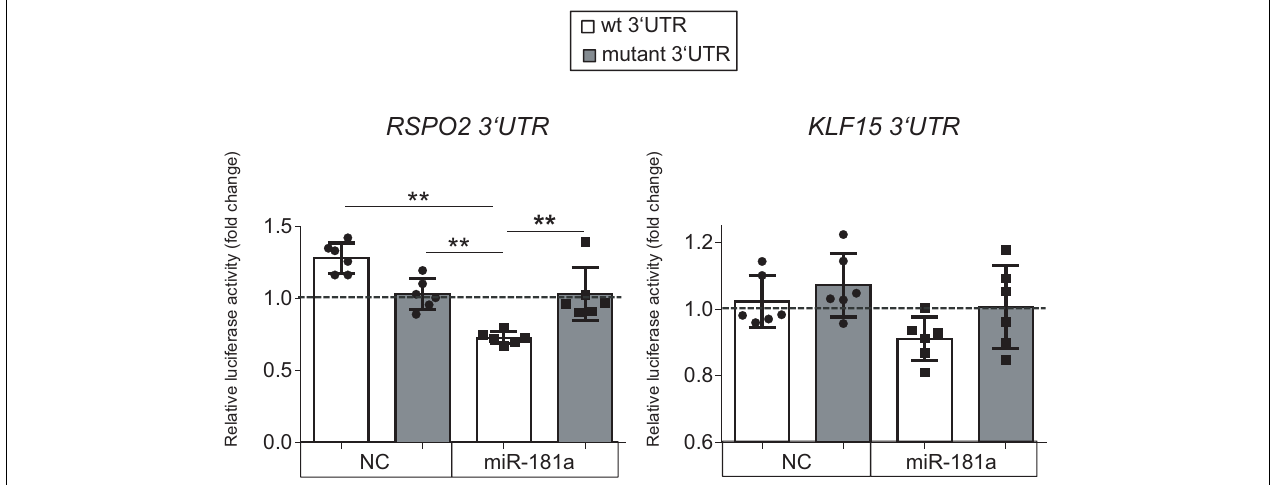
FIGURE 2 | Luciferase reporter assay done in HEK293T cells with pMIR-REPORT vector either containing the wild-type (wt, white) or a mutated 3 (cid:48) -UTR (gray) fragment of the indicated mRNA as a putative binding site for miR-181a. The control reporter was containing the binding site for a non-targeting control miR (NC). The gray dotted line indicates levels of binding for an empty pMIR-REPORT vector; n = 6; error bars correspond to mean values ± SD; **p ≤ 0.01 (Two-way